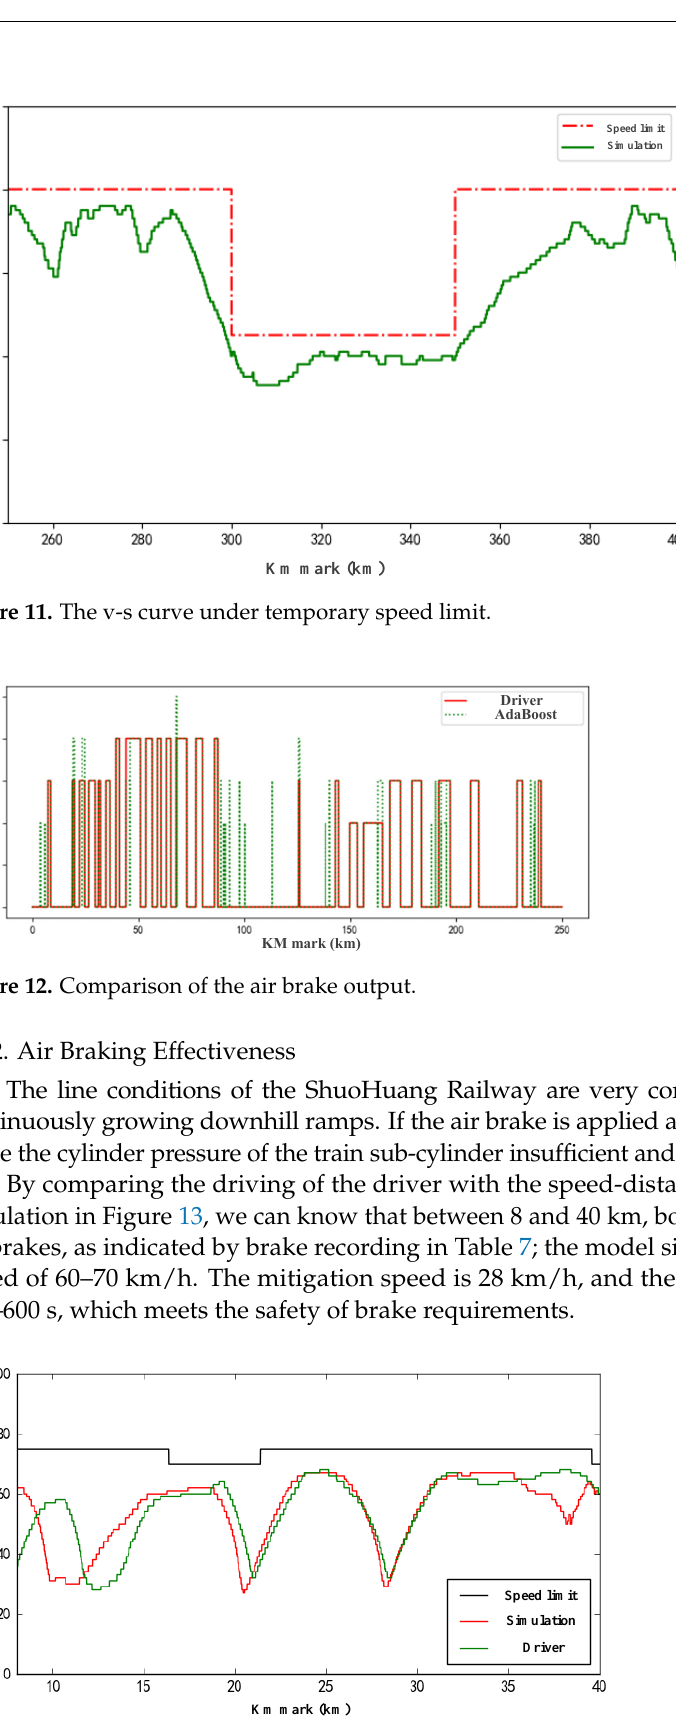
Figure 13. Comparison of v-s on continuous growth